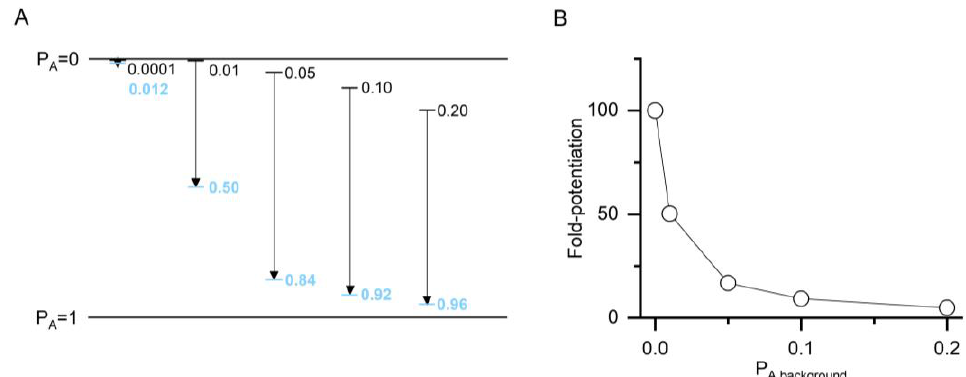
Figure 2. The relationship between apparent potentiation and the value of c compound . ( A ) The plot shows imposed P A,background (black lines and numbers) and calculated P A,compound (blue lines and numbers) for a hypothetical compound with two binding sites (N = 2) and a c compound of 0.100 ( ∆ G = − 2.72 kcal/mol). The calculations were done at a saturating concentration (1000 × of K resting ) and thus reflect maximal effects. Higher P A is shown downward for consistency with the direction of current flow in electrophysiological recordings from GABA A receptors. ( B ) The graph shows fold-potentiation at different P A,background calculated from the data in panel A. The compound has a larger apparent potentiating effect when measured at low P A,background